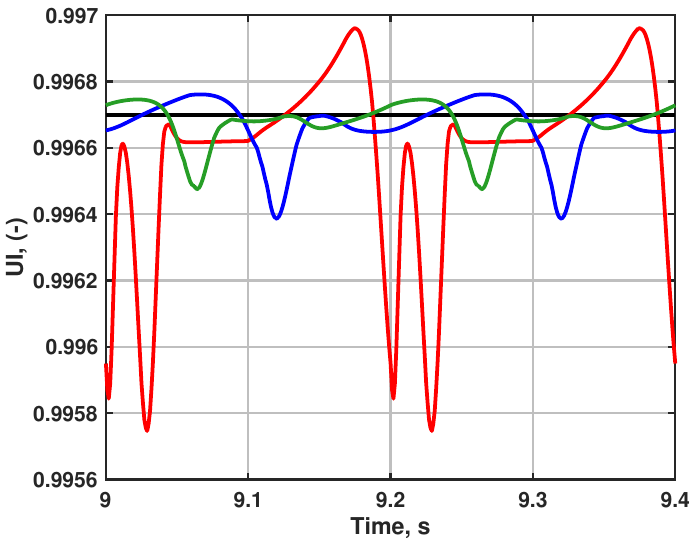
Figure 6. Uniformity index of reactant field half-way through the monolith brick over time as obtained in cases 1 (black), 2 (red), 3 (blue) and 4